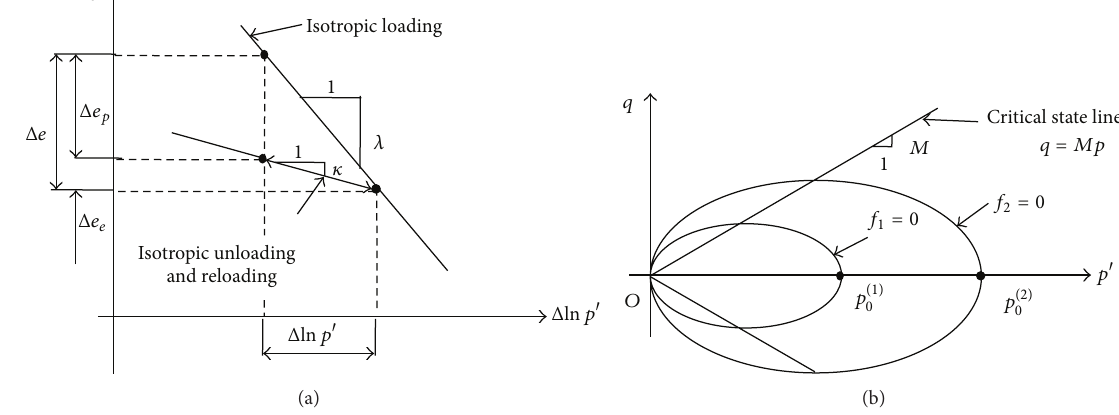
Figure 3: Criterion of the Cam-clay model of: (a) loading/unloading/reloading in 𝑒 -ln 𝑝 space; (b) yield surface on 𝑝 󸀠 - 𝑞 space [15].